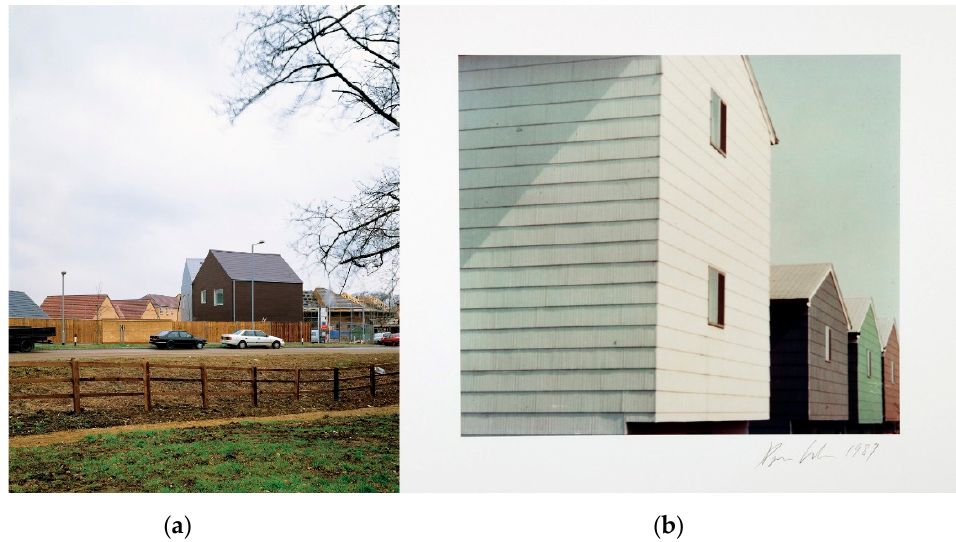
Figure 3. ( a ) Suburban Housing, Stevenage, 2000, Sergison Bates. © Sergison Bates. ( b ) Homes for America, Dan Graham, 1966. © Dan Graham.